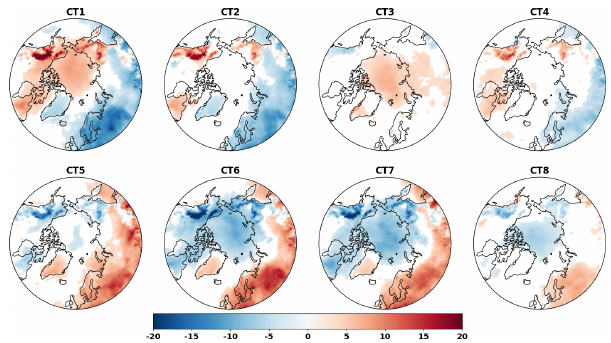
Figure 6. The 925hPa O 3 anomalies (ppbv) based on CAMS data for the eight circulation types. Only those anomalies that are statis- tically significant at the 90% confidence level are